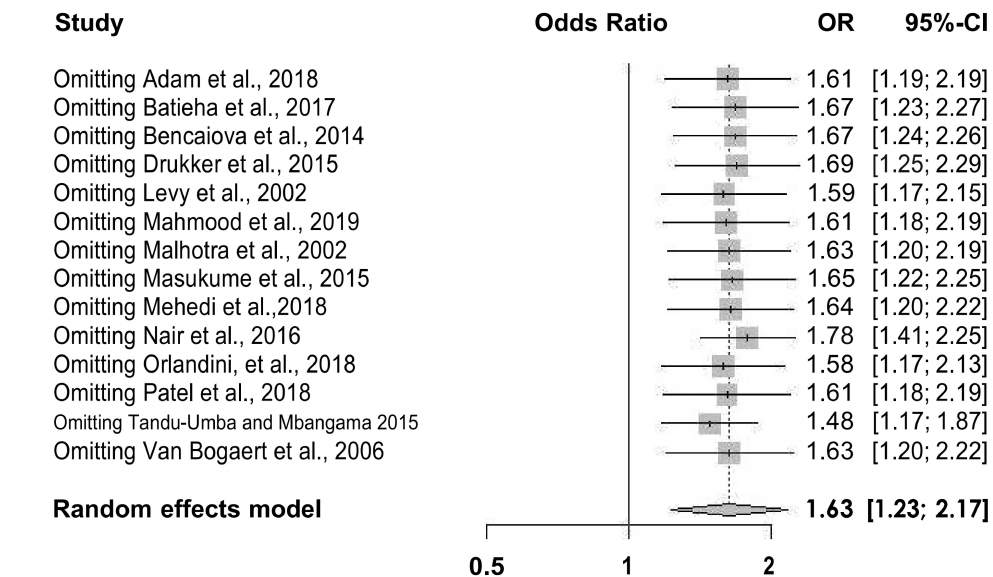
Figure 5. Sensitivity analysis performed by removing one study at a time. Published data from Adam et al. [27], Batieha et al. [25], Bencaiova et al. [26], Drukker et al. [10], Levy et al. [6], Mahmood et al. [28], Malhotra et al. [19] Masukume et al. [8] Mehedi et al. [20] Nair et al. [24] Patel et al. [9] Orlandini et al. [21] Tandu-Umba et al. [22] and Van Bogaert et al. [23] were used to calculate the pooled OR and perform the sensitivity analysis.